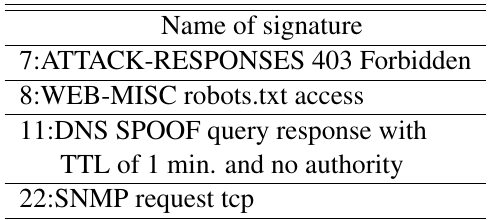
Table 2: Name of the major target signatures. Name of